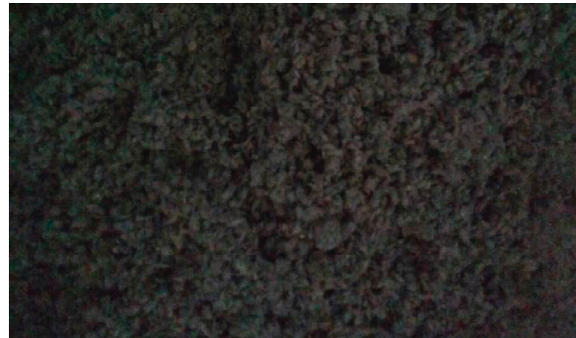
Figure 1: Real photo of the mixed material.